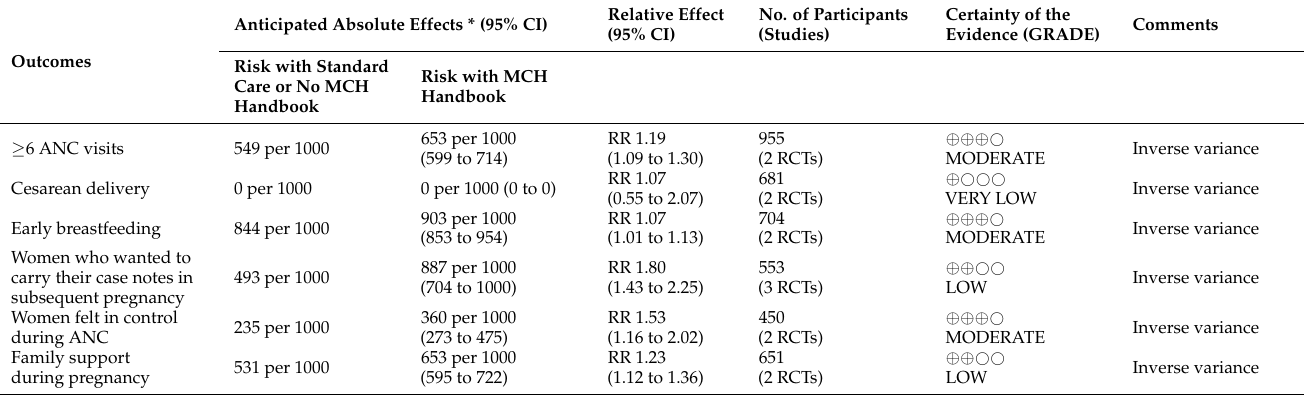
Table 1. Summary of